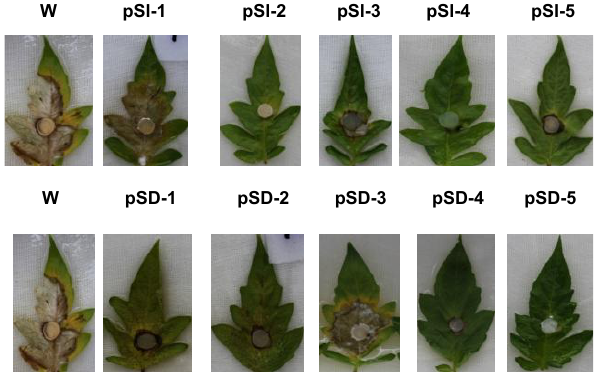
Figure 6. Pathogenicity of the wild-type and transformant strains: lesion development on tomato leaves. Leaves were inoculated with an agar plug (5 mm in diameter) of each